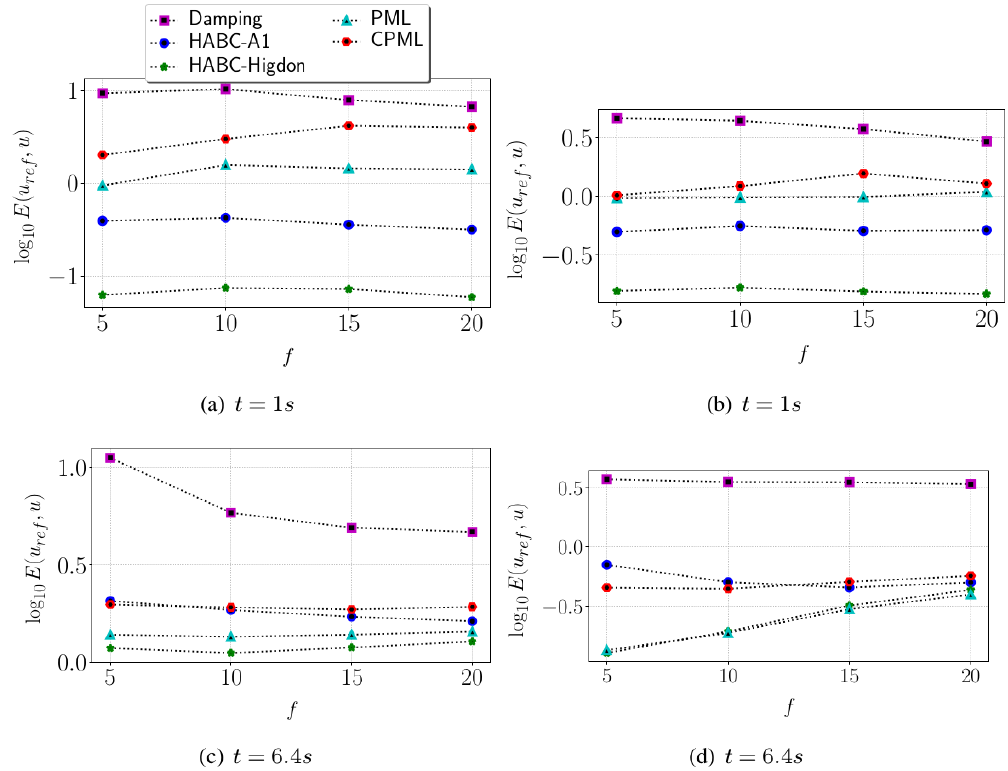
Figure 8. Error curves of the forward solution ( u ) with respect the frequency peak f of Ricker wavelet. The analyses considered the wave solutions for the velocity models, including a circle (a) , a heterogeneous model built with horizontal layers (b) , part of the Marmousi model (c) , and the 2D SEG/EAGE salt velocity model (d) .